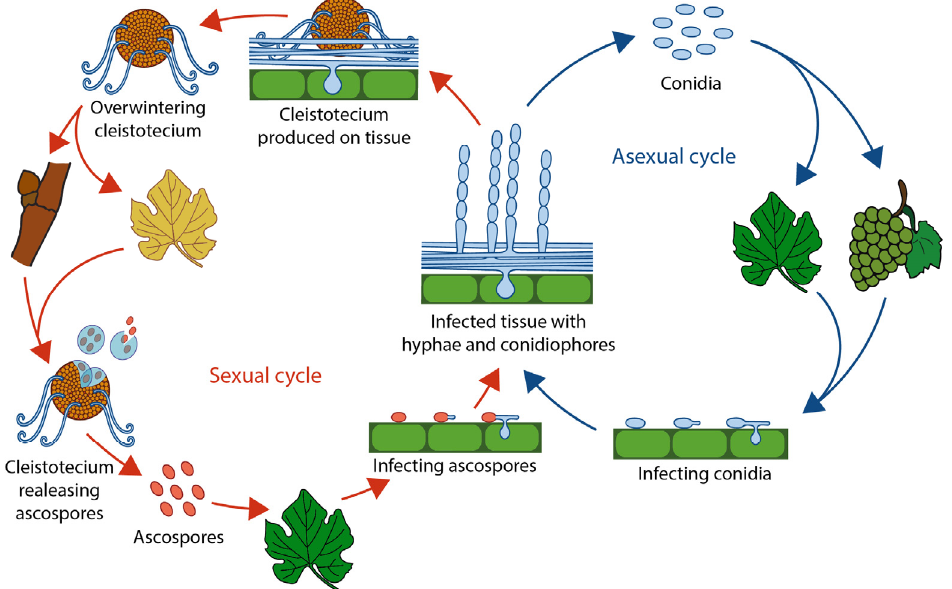
Figure 2. Schematic diagram of the disease cycle of powdery mildew caused by Uncinula necator . Red arrows refer to the sexual cycle. Blue arrows refer to the asexual cycle.